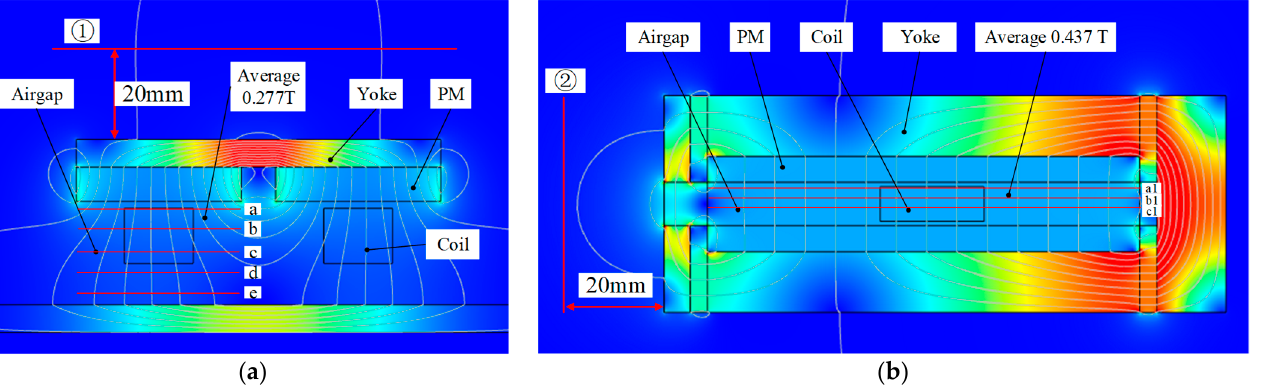
Figure 8. Flux density distribution of the driving unit and ejection unit: ( a ) driving unit of the conveying platform and ( b ) ejection unit of the launcher.